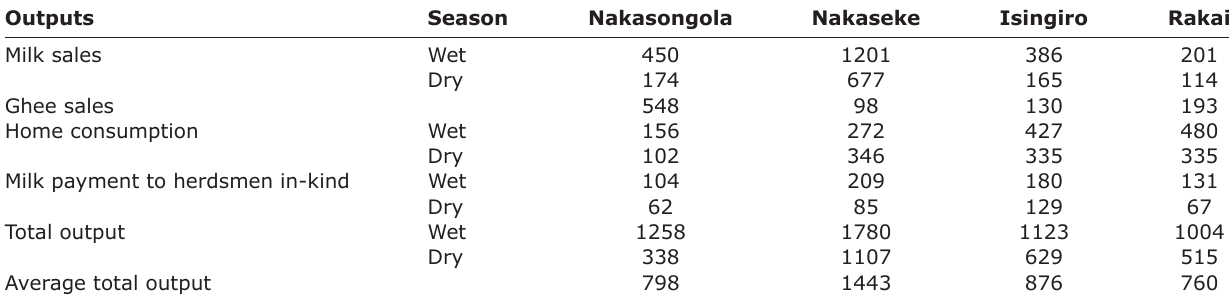
Table-3: Normal average age-specific prices of cattle (US dollars) in the study districts. Category